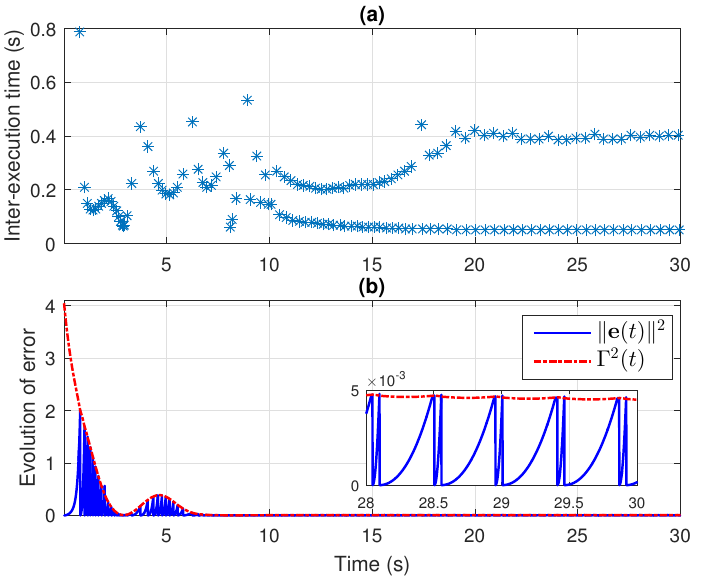
Figure 7. ( a ) The inter-update time response ( T ) of the proposed ET scheme, ( b ) the time evolution of (cid:107) e (cid:107) 2 and Γ 2